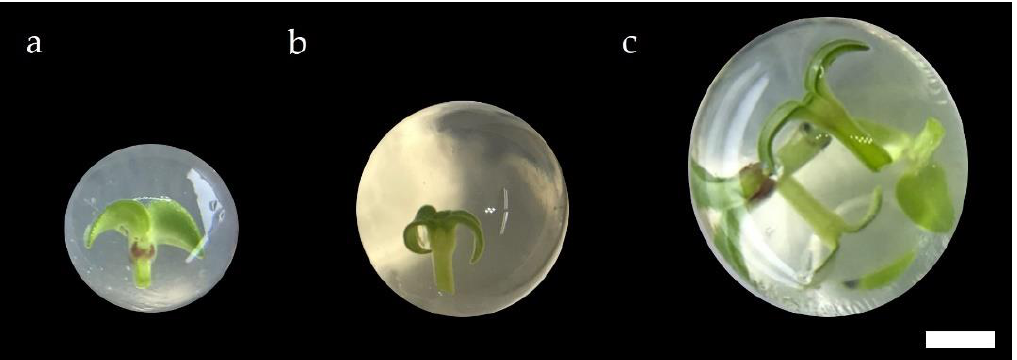
Figure 1. Appearance of alginate-encapsulated structures (( a ): a Persian violet microshoot encapsu- lated with a single layer of alginate (a synthetic seed); ( b ): a microshoot encapsulated with a double layer of alginate (a synthetic seed); ( c ): five microshoots encapsulated within a single layer of alginate (a synthetic fruit); scale bar = 2 mm).